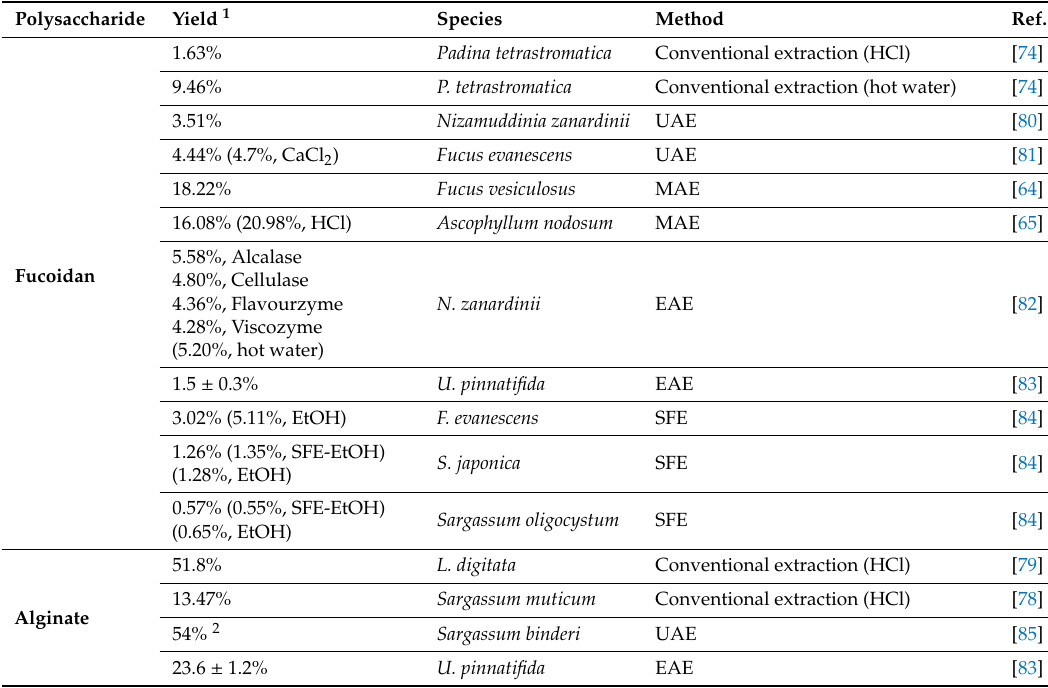
Table 3. Extraction yields from di ff erent extraction